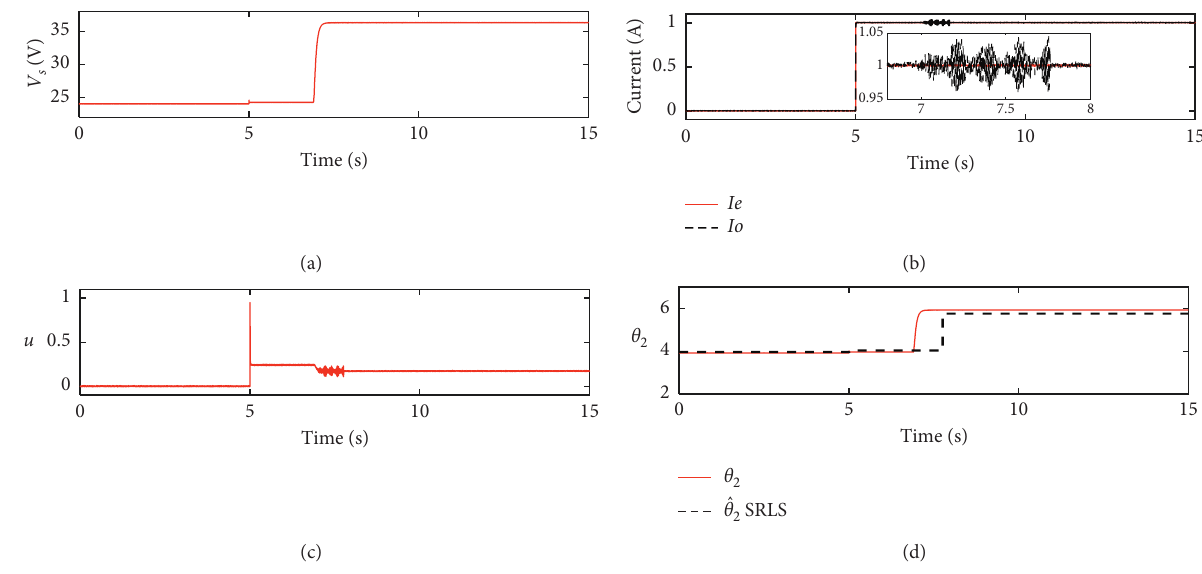
Figure 21: The results of the system using AADRC with V